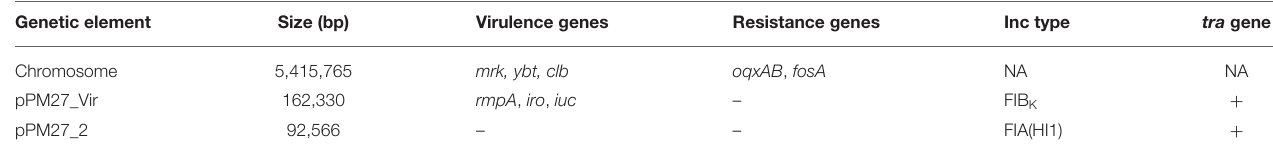
TABLE 2 | Genetic characterization of the K. pneumoniae strain PM27. Genetic